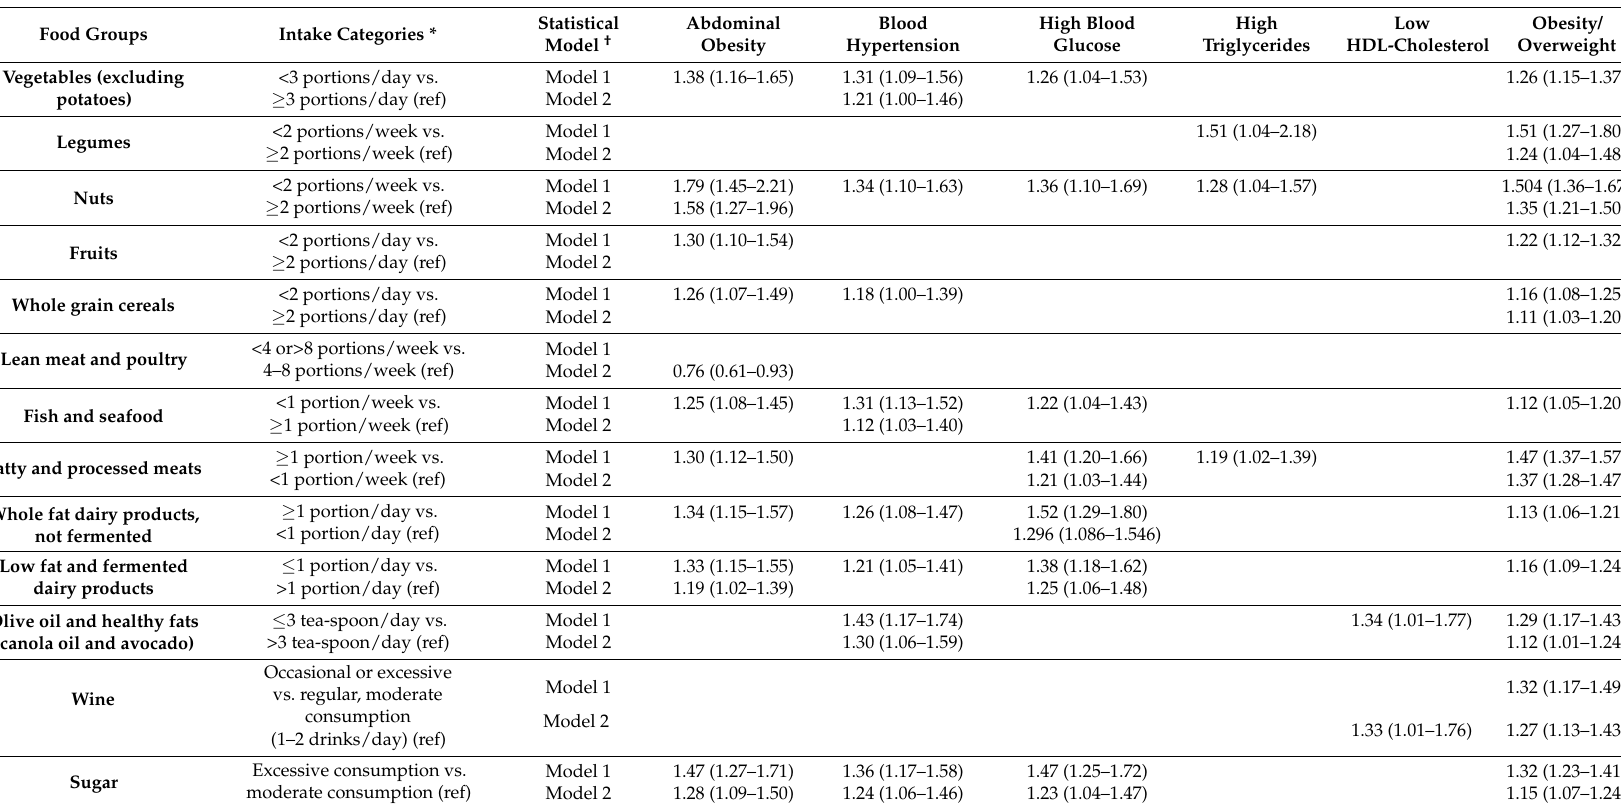
Table 3. Adjusted odds ratios for metabolic syndrome components and obesity/overweight by individual Chilean-MDI food